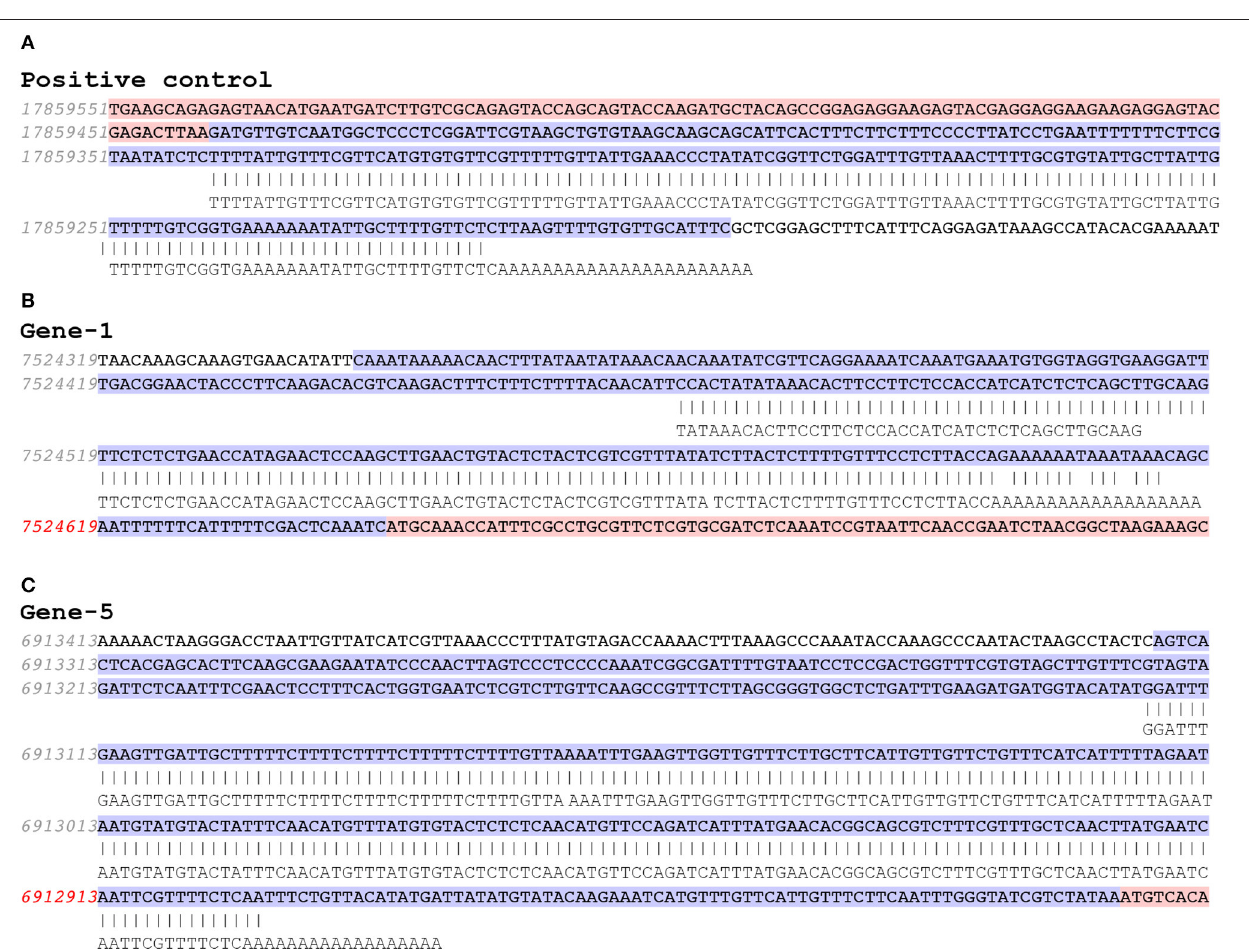
FIGURE 2 | Representative sequence alignment to the Arabidopsis genome. DNA sequences are aligned to the Arabidopsis genome to confirm the selected poly(A) sites. The upper sequence in each panel is genome sequence, where blue shows 5 ′ -UTR and red shows coding region. Numbers in red show the predicted PAC sites (Guo et al., 2016). The lower aligned sequence in each panel shows sequencing results. (A) Positive control is a 3 ′ -UTR poly(A) site for a β -tubulin gene. (B) For gene no. 1 (AT5G22630), the poly(A) site is not real in that the band is generated by binding to a long stretch of adenines in the genome sequence. (C) For gene no. 5, (AT5G20450) the poly(A) tail is verified, because there isn’t a long stretch of adenines in the corresponding genome sequence.